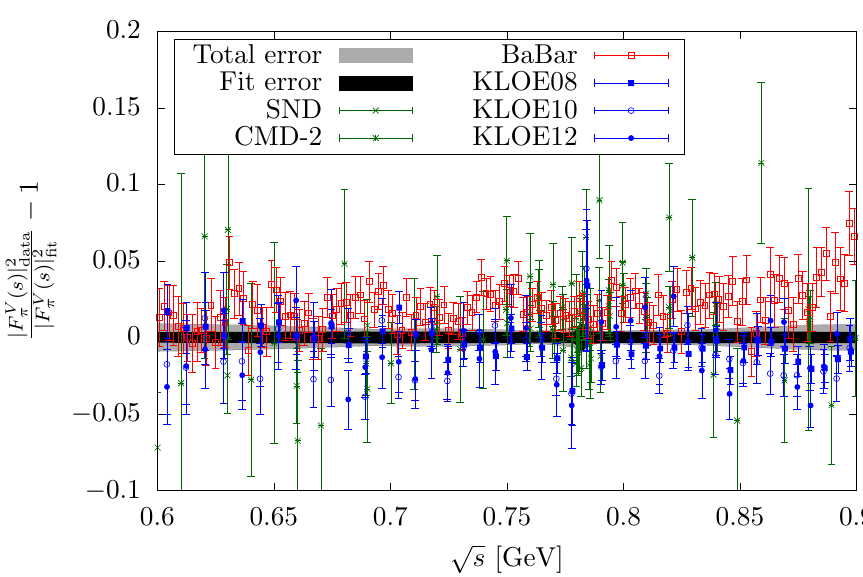
Figure 12. Relative di(cid:11)erence between the data points (including the energy rescaling (4.10)) and the (cid:12)t result for the VFF, normalized to the (cid:12)t result for j F V errors and total uncertainties as two separate error bands. The total uncertainty is given by the (cid:12)t error and the systematic uncertainty, added in quadrature.